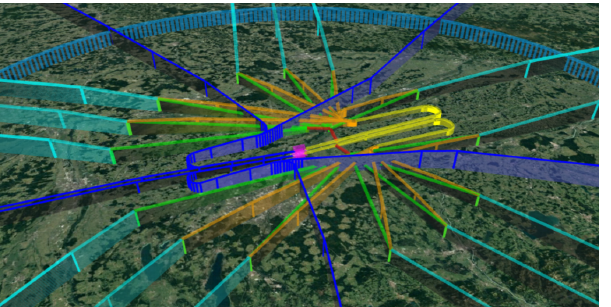
Figure 3. E-TMA with distinction into 3D (orange lines) and 4D (green lines) arrival paths. Red = direct-only merge points and routes, purple = touchdown